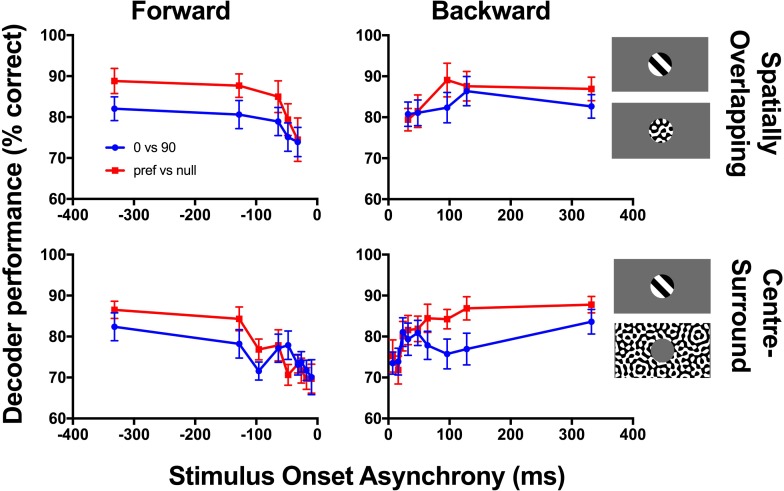
Decoding of V1 neuronal responses predicts that perceptual discrimination of orientation will decrease as stimulus onset asynchrony (SOA) approaches zero.We generated 200 pseudopopulations of 20 neurons, selected randomly without replacement. For each pseudopopulation we simulated 10,000 trials of horizontal and vertical target gratings (blue) or gratings with preferred and null orientations (red). We used Fischer’s linear discriminant to predict the stimulus orientation. The decoder was trained and tested separately for each spatial condition and for each SOA. Error bars indicate standard deviation across the 200 decoded pseudopopulations.